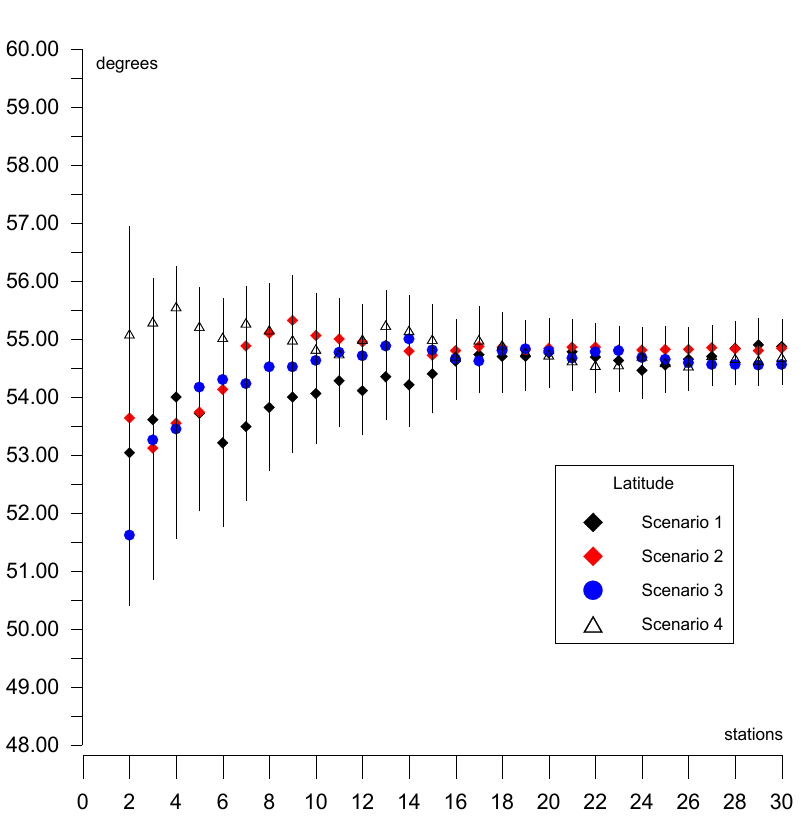
Figure 4. Results of the sequential solutions of the Φ parameter for four calculation scenarios. Sensors 2020 , 20 , x